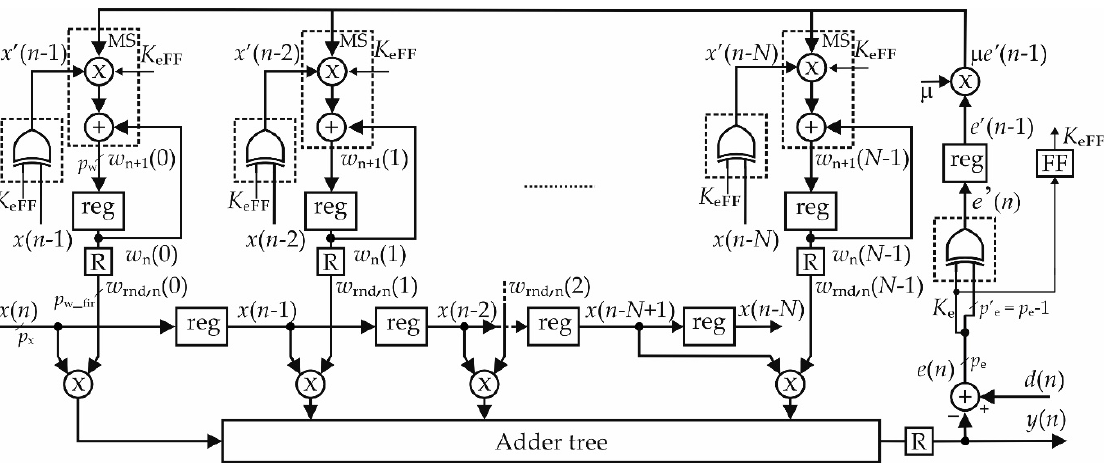
Figure 3. Block diagram of the DLMS filter with sign–magnitude technique. The dashed square with the XOR gate represents the XOR bank, whereas, in the learning, the dashed rectangles highlight the sign–magnitude (MS) MAC blocks.